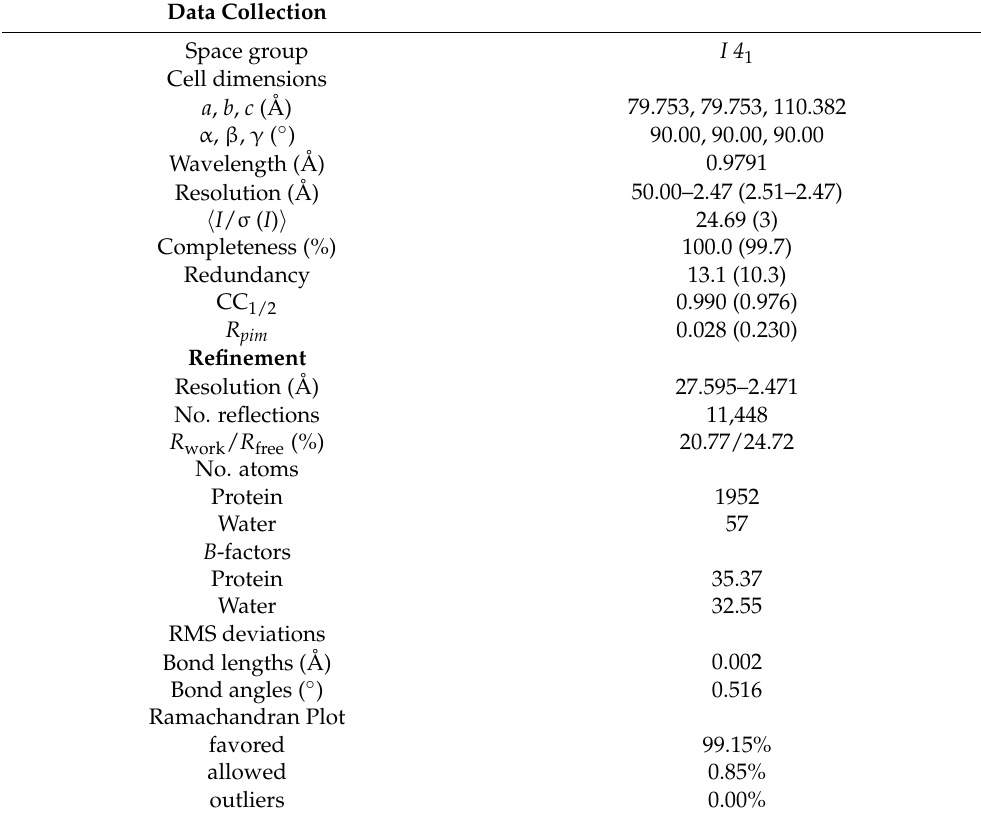
Table 1. X-ray data collection and refinement